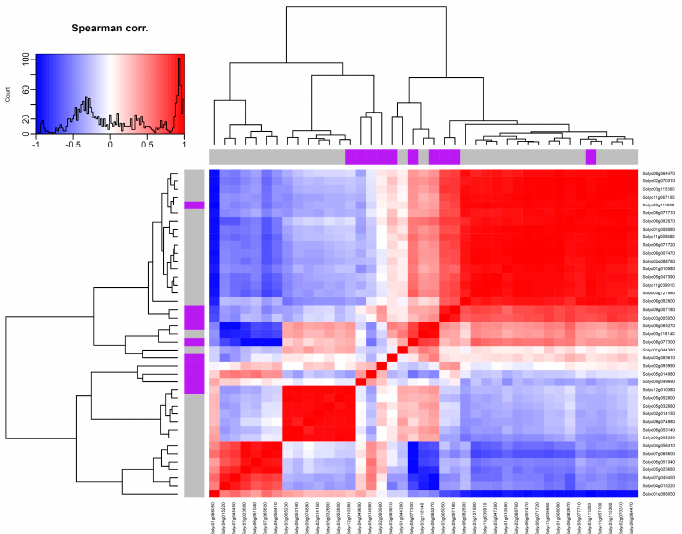
Figure 9. Correction heatmap of SlADK genes. Based on the calculation of the correlation values, correlation gene pairs were visualized as a heatmap after a hierarchical clustering to highlight the positively and negatively correlated groups. For a given row of the heatmap, red and blue colors represent positive and negative correlation coefficients, respectively. Purple colors represent SlADK family members. The diagonal line from the lower left corner to the upper right corner of the heat map shows the same gene, and the default correlation coefficient is 1.